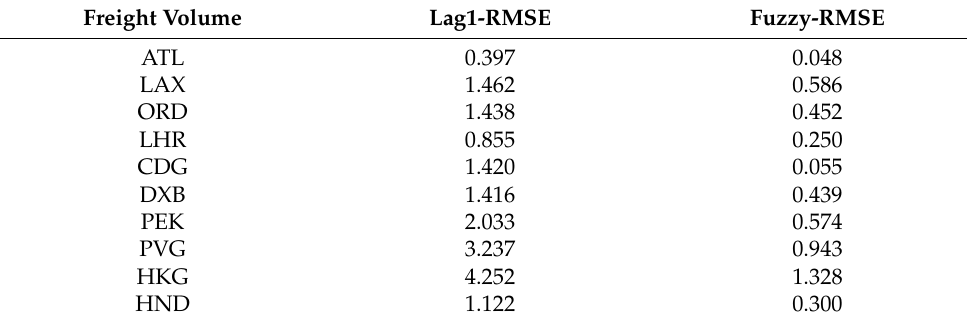
Table 7. Fuzzy air freight traffic time series